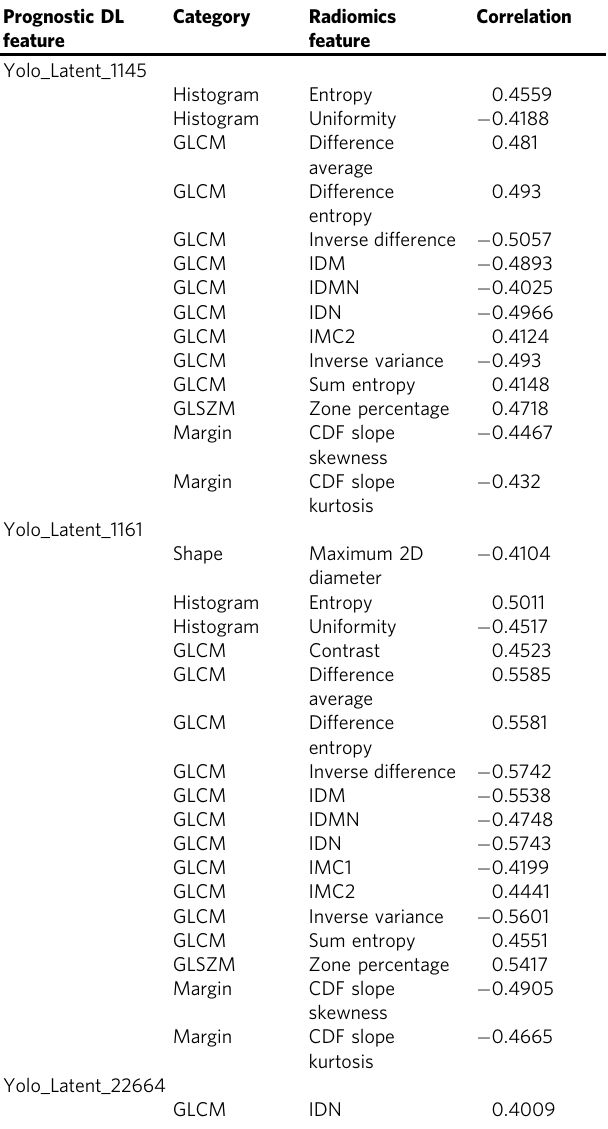
Table 4 DL (Yolo) risk score model for prognosis and the associated DL